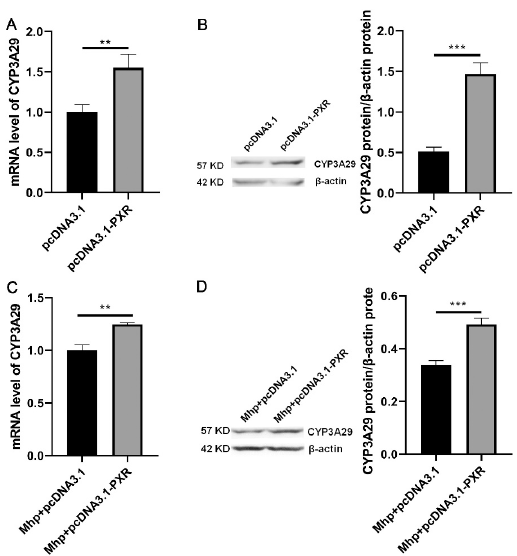
Figure 4. Effect of PXR overexpression on CYP3A29 expression in PAM 3D4/21 cells with or without M. hyopneumoniae infection. ( A ) The mRNA expression level of CYP3A29 after PXR overexpression. ( B ) pcDNA3.1 or pcDNA3.1- PXR was transfected into PAM 3D4/21 cells. The protein expression of CYP3A29 was measured by western blot. ( C ) The mRNA expression level of CYP3A29 after PXR overexpression in PAM 3D4/21 cells infected with M. hyopneumoniae . ( D ) pcDNA3.1 or pcDNA3.1- PXR was transfected into PAM 3D4/21 cells infected with M. hyopneumoniae . The protein expression of CYP3A29 was measured by western blot. The data are presented as the mean ± SD. The experiment was repeated three independent times. ** p < 0.01; *** p < 0.001. Animals 2021 , 11